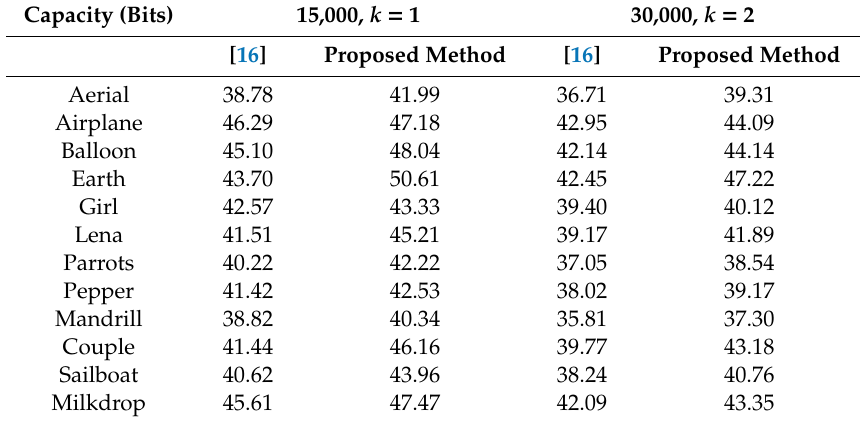
Table 3. Peak signal-to-noise ratios (PSNRs) of Imaizumi et al.’s [16] and the proposed methods.